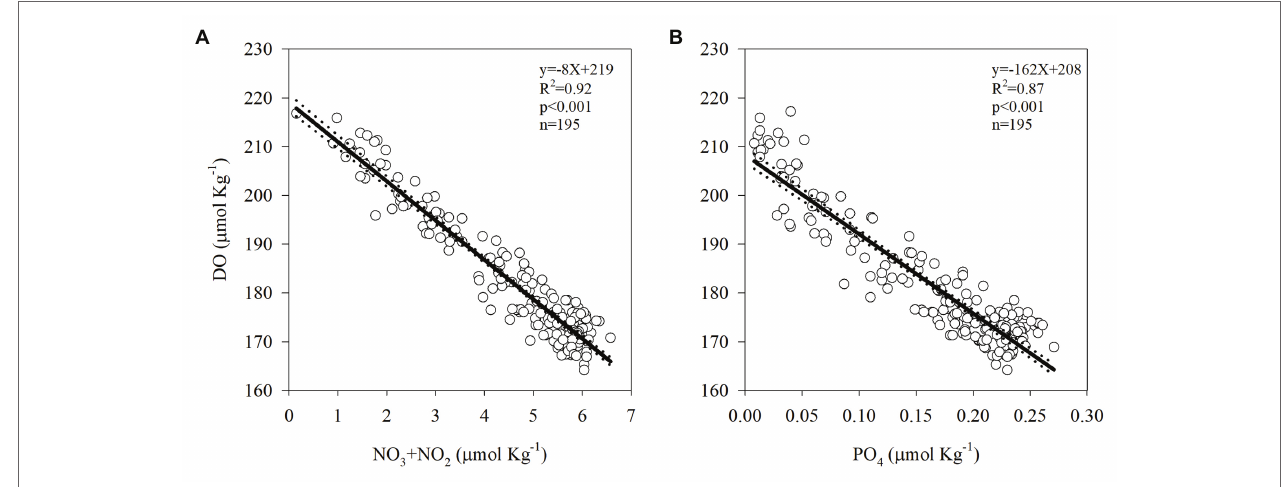
FIGURE 6 | Correlations between (A) DO:NO 3 + NO 2 and (B) DO:PO 4 within the depth range of the nutricline (200–600 m), where the majority of the organic matter sinking from the surface layer is re-mineralized in the SEMS. The solid line shows the regression trend-line while the dotted lines show the 95% CI. The data compiling this figure are from stations H05, H06, and